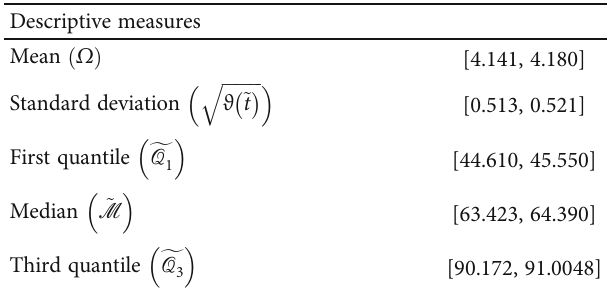
Table 4: Neutrosophic summary of the bearing balls dataset.